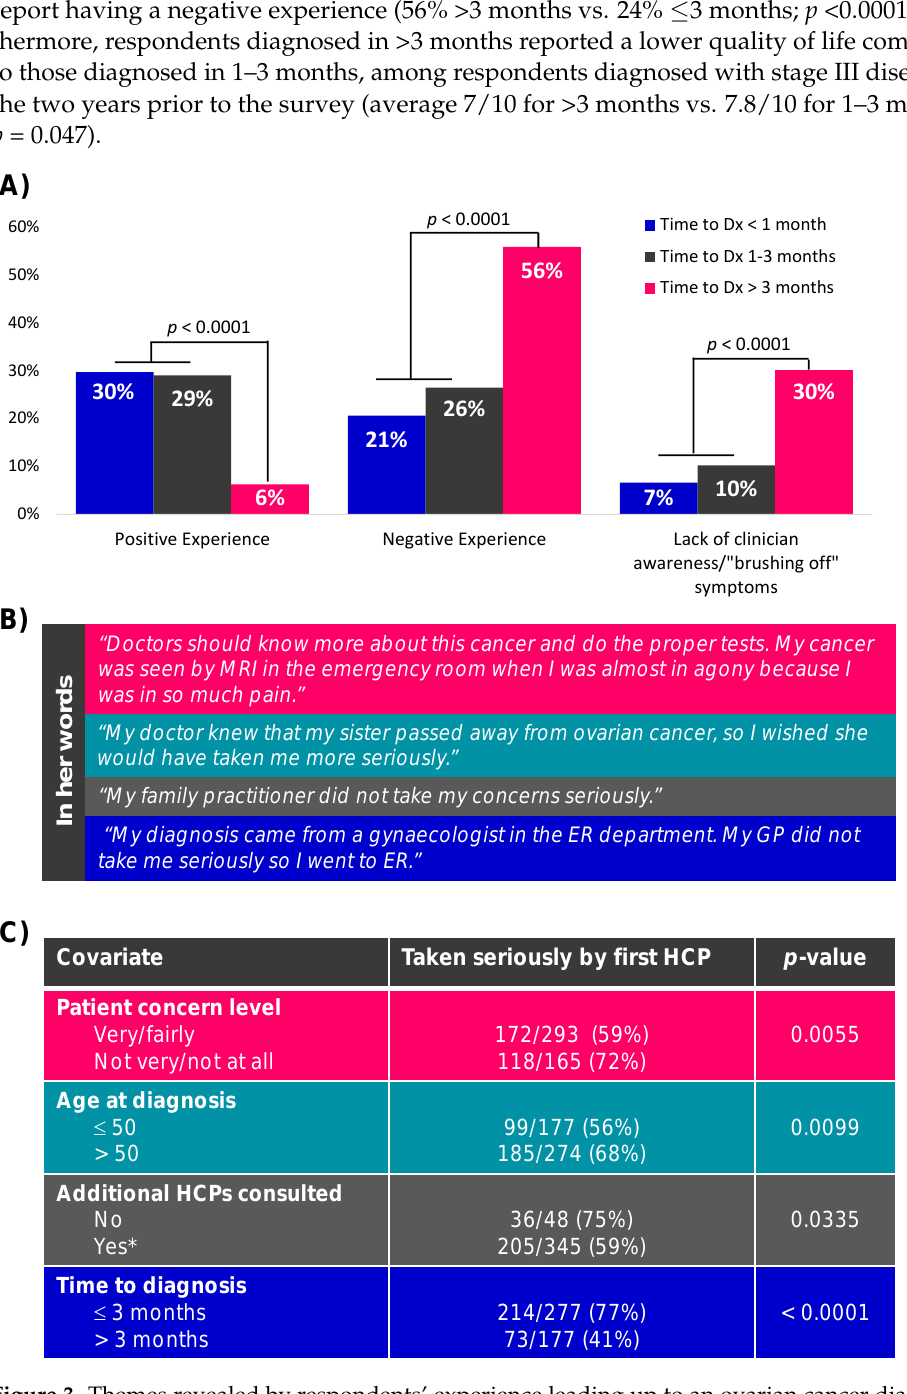
Figure 3. Themes revealed by respondents’ experience leading up to an ovarian cancer diagnosis. Whether a respondent had an overall positive or negative experience, and the most common theme among negative experiences is shown in panel ( A ). Direct quotes from free-text responses highlighting common themes are shown in panel ( B ). Variables impacting (and impacted by) whether a respondent felt their concerns were taken seriously are shown in panel ( C ). * includes 63% of those who saw one additional HCP, 57% of those who saw two additional HCPs and 51% of those who saw ≥ 3 additional HCPs. Dx = diagnosis; HCP = healthcare provider. Many respondents (63%) who consulted a healthcare provider about their symptoms felt that their concerns were taken seriously. However, women who were ≤ 50 years old ( p